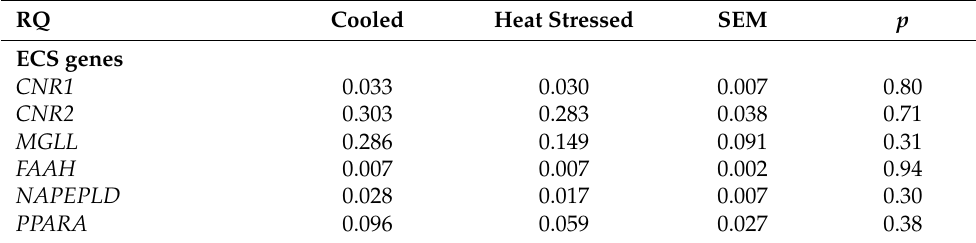
Table 5. Relative mRNA expression in AT of cooled vs. heat-stressed late-lactation cows. RQ Cooled Heat Stressed SEM p ECS genes CNR1